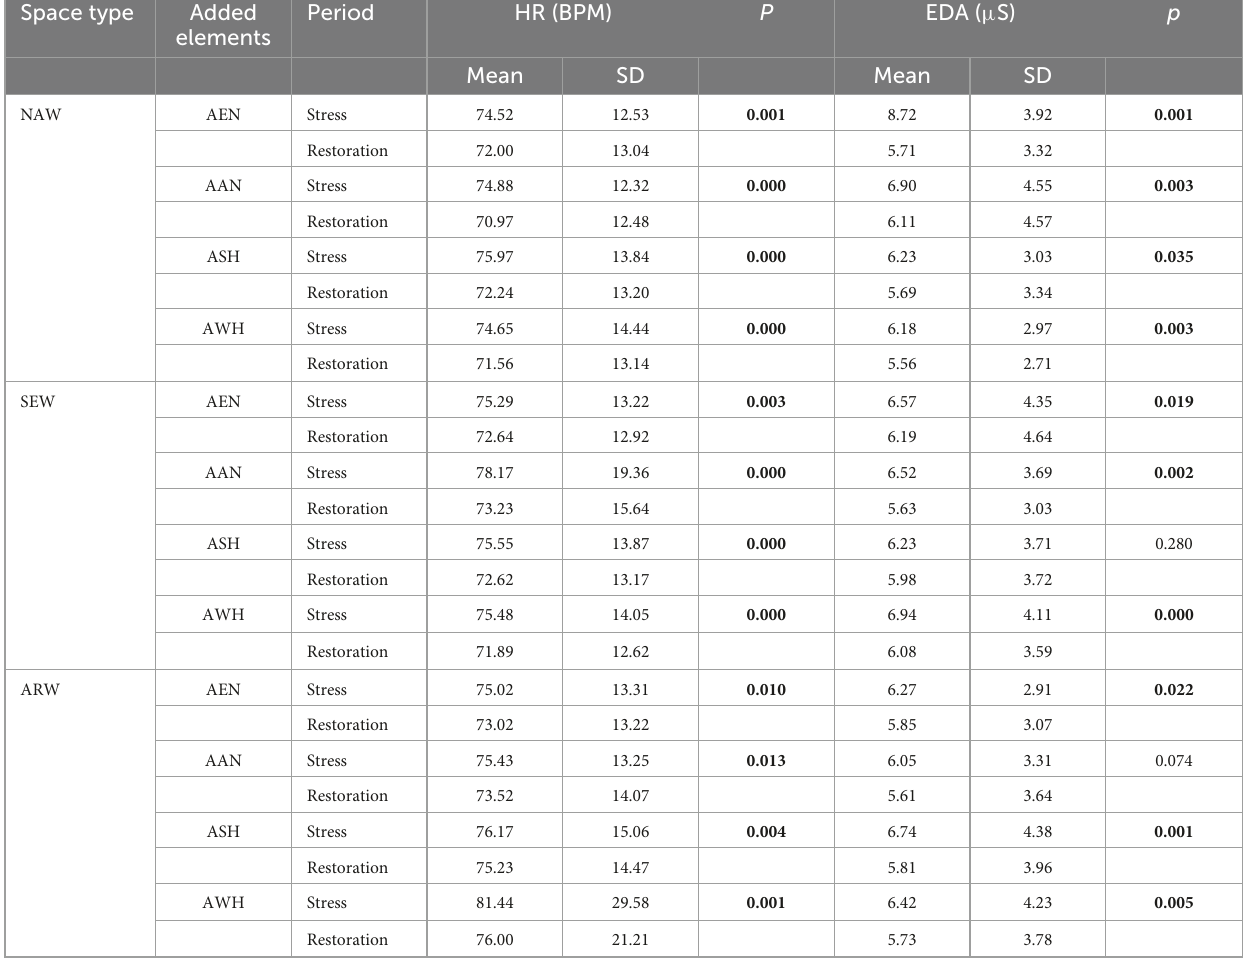
TABLE 3 Effects on subjects’ HR and EDA after adding different audio elements to NAW, SEW, and ARW. Space